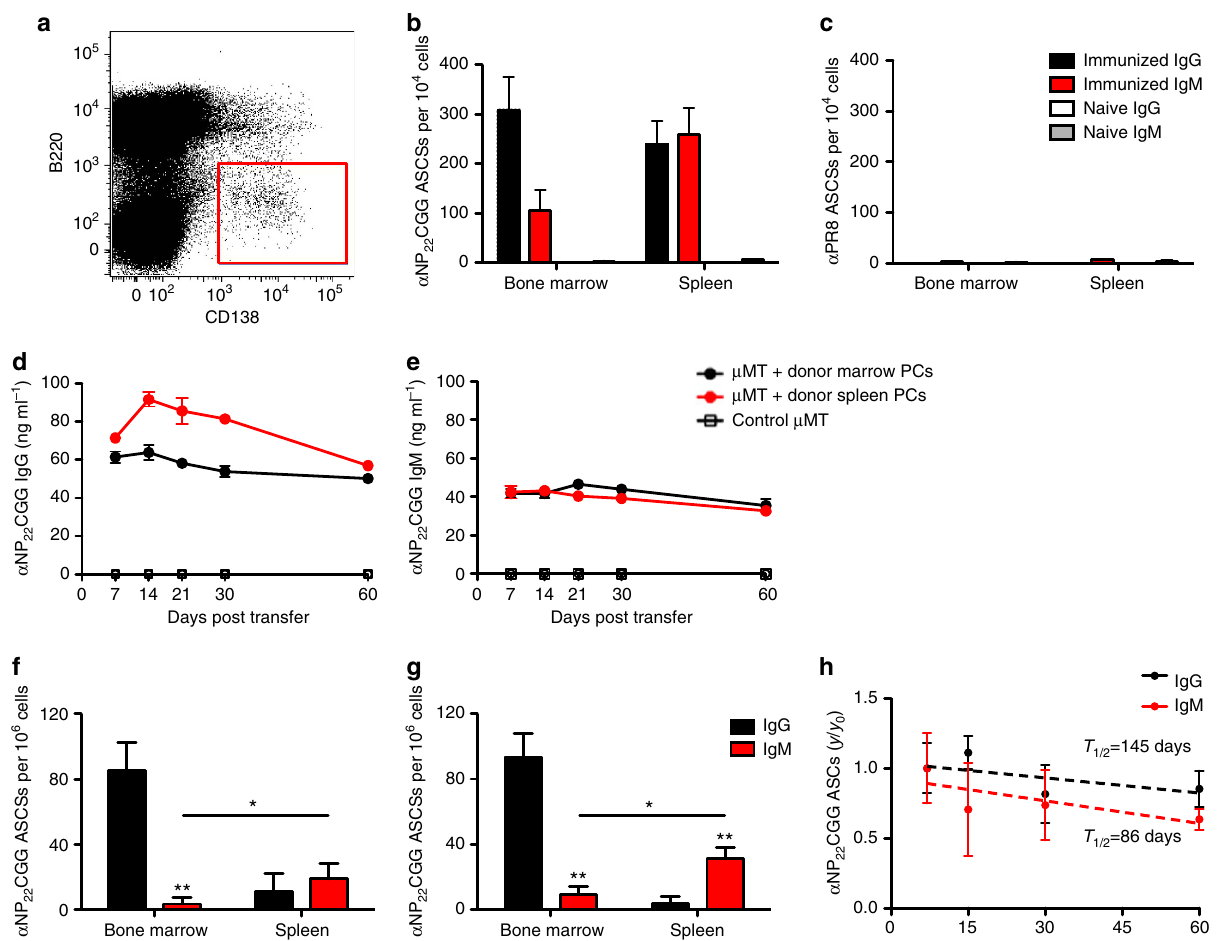
Figure 2 | Antigen-specific, IgM LLPCs persist post-adoptive transfer and preferentially localize in the spleen. ( a ) Representative CD138 þ B220 (cid:2) PC gating strategy for FACS. ( b ) NP 22 CGG-specific IgG (filled black square) and IgM (filled red square) ASCs in 10 4 sorted PCs, 2 months post-NP 22 CGG immunization ( n ¼ 3) or in age-matched controls (open black square, n ¼ 3). ( c ) Nonspecific (A/PR/8/34 binding) ASCs in 10 4 sorted PCs, 2 months post- NP 22 CGG immunization ( n ¼ 3) or in age-matched controls ( n ¼ 3). ( d ) Antigen-specific serum IgG titres found in recipient m MT mice that have been adoptively transferred with bone marrow PCs (black circles) or splenic PCs (red circles) as measured by ELISA at days 7 through 60 ( n ¼ 5). ( e ) Antigen- specific serum IgM titres found in recipient m MT mice that have been adoptively transferred with bone marrow PCs (black circles) or splenic PCs (red circles) as measured by ELISA at days 7 through 60 ( n ¼ 5). ( f ) Localization of donor, NP 22 CGG-specific IgG (filled black square) and IgM (filled red square) ASCs, adoptively in bone marrow PC recipient mice. ( g ) Localization of donor, NP 22 CGG-specific IgG (filled black square) and IgM (filled red square) ASCs, adoptively in splenic PC recipient mice. The mean ( ± s.e.m.) of five immunized mice or three naive controls is shown, with ** indicating Student’s t -test P o 0.005. ( h ) The half-life of transferred cells was determined by fitting the time-course data of either IgG or IgM PCs in splenic recipient mice ( n ¼ 4) as a function of their ratio ( y / y initial ) with its linear